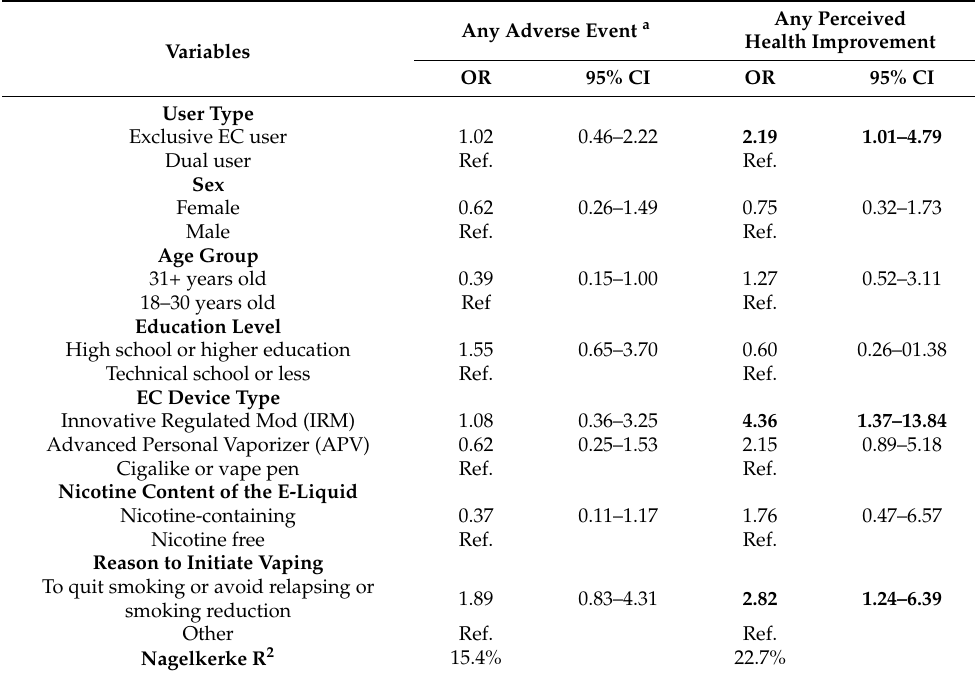
Table 4. Predictors of adverse events and perceived health improvement due to e-cigarette use among current daily users: Multiple binary logistic regression analyses.